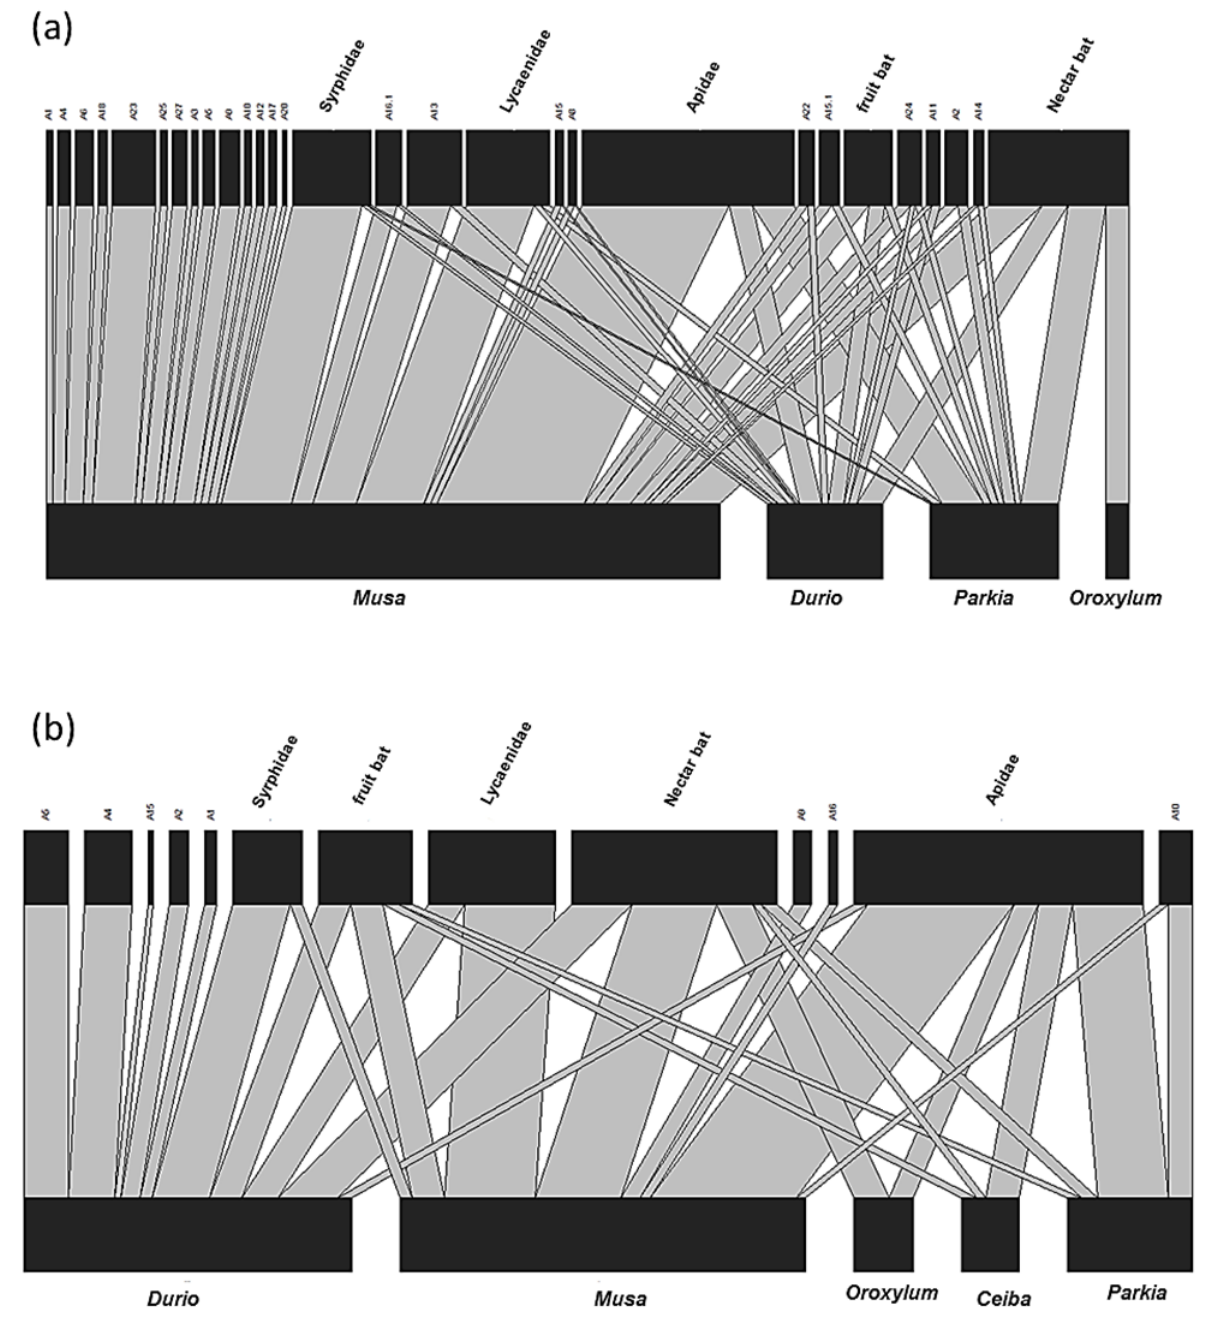
F IGURE 1. Quantitative pollination networks at mixed fruit orchards in southern Thailand (A) near the forest edge and (B) far from the forest edge. For each web, lower bars represent plant abundance and upper bars represent animal visitor abundance. Linkage width indicates frequency of each plant-animal